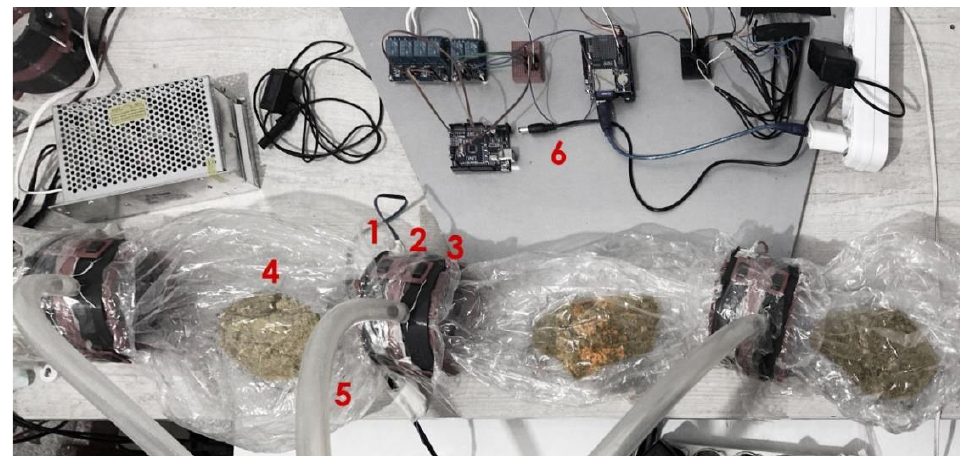
Figure 6. MCB contamination control experiment setup: 1, humidity/temperature sensor; 2, CC; 3,